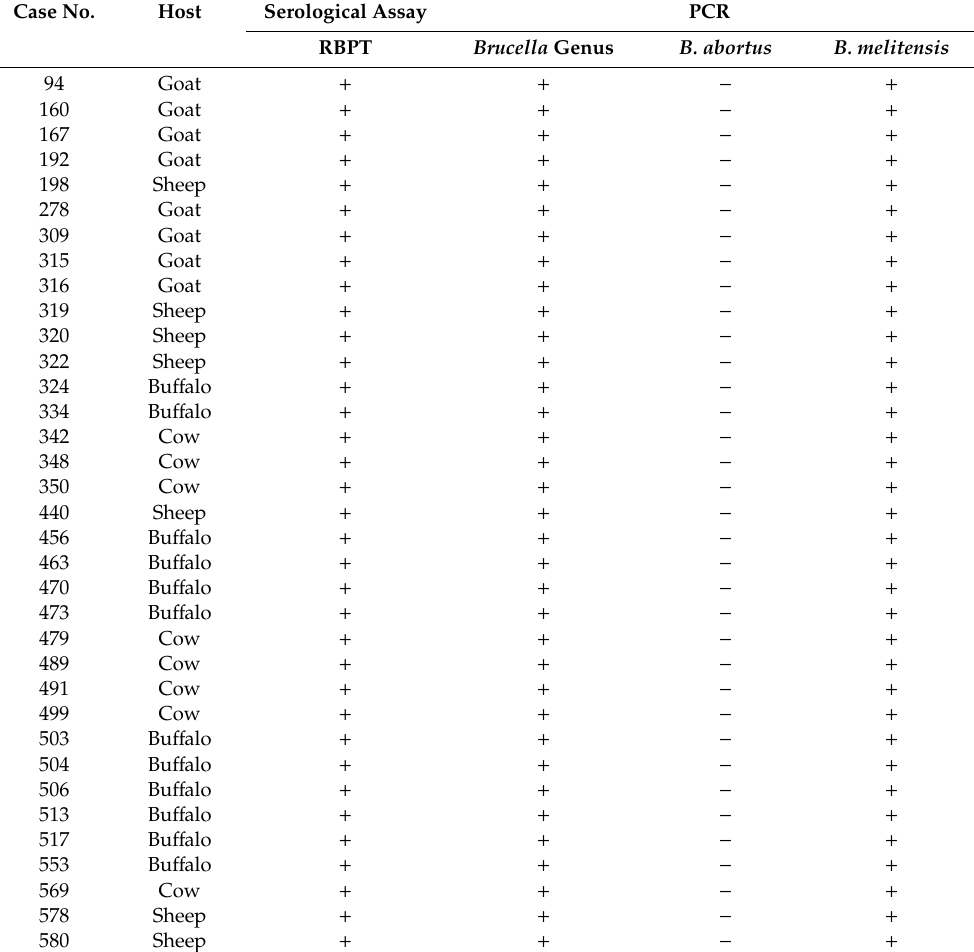
Table 5. Seroprevalence and molecular detection of Brucella DNA in tested serum samples. Case